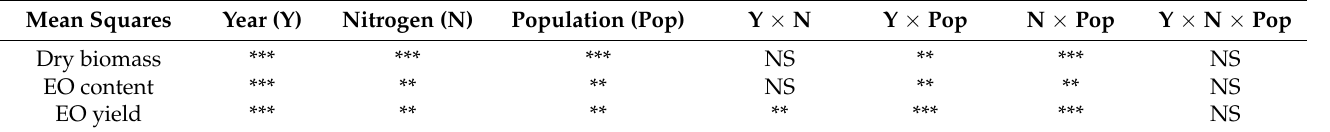
Table 1. Analysis of variance to examine the relationships between dry biomass production (Mg ha − 1 ), essential oil (EO) content (mL 100 g − 1 DW) and essential oil (EO) yield (L ha − 1 ) with respect to cultivation year (Y), nitrogen level (N) and population (Pop), for all of the five Greek oregano populations (1-Panagia, 2-Litochoro, 3-Omolio, 4-Papadates, 5- Vytina) combined, grown at four different nitrogen supply levels (control, N1, N2, N3, that correspond to 0, 40, 80 and 120 kg N ha − 1 , respectively) and measured over a three-year period (2010–2012).